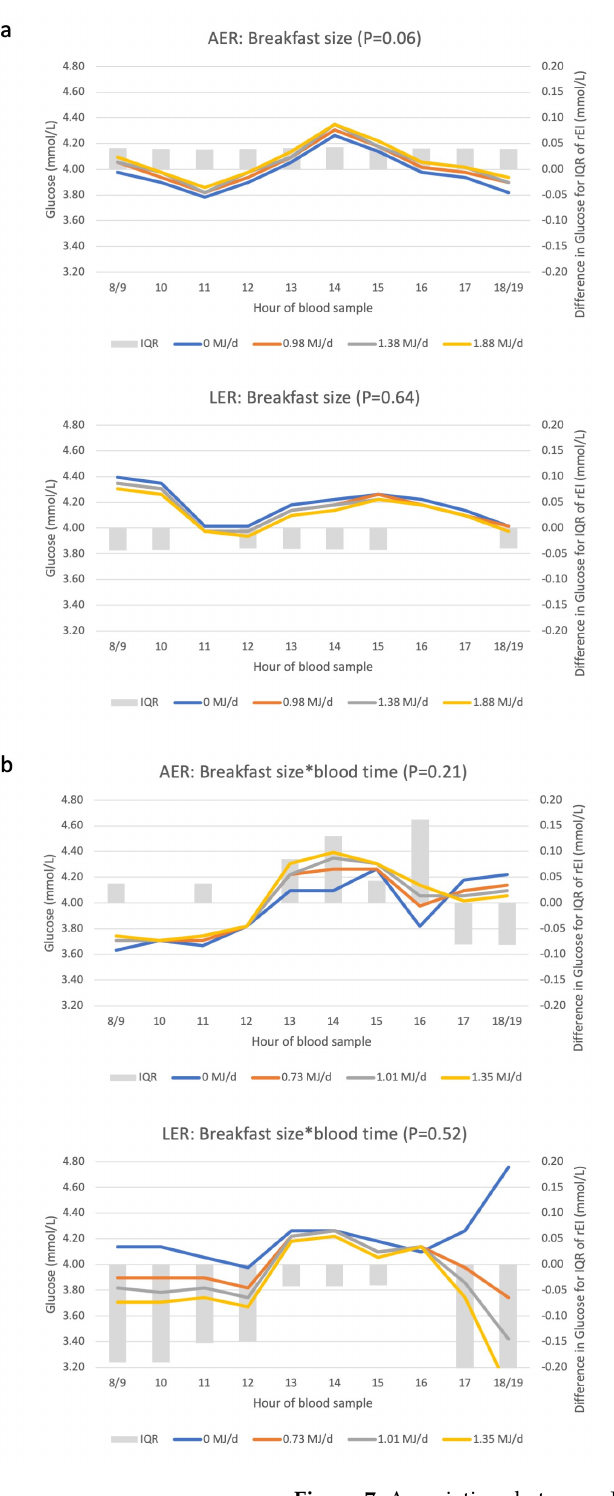
Figure 7. Associations between rEI (‘meal size’) and glucose concentrations by reporting status in men ( a ) and women ( b ). Abbreviations: AER, acceptable energy reporter; DEI, daily energy intake (MJ/d); IQR, interquartile range; LER, low energy reporter; rEI, reported energy intake. See Appendix D for a description of the axes and Table S3 for a description of LER and AER.